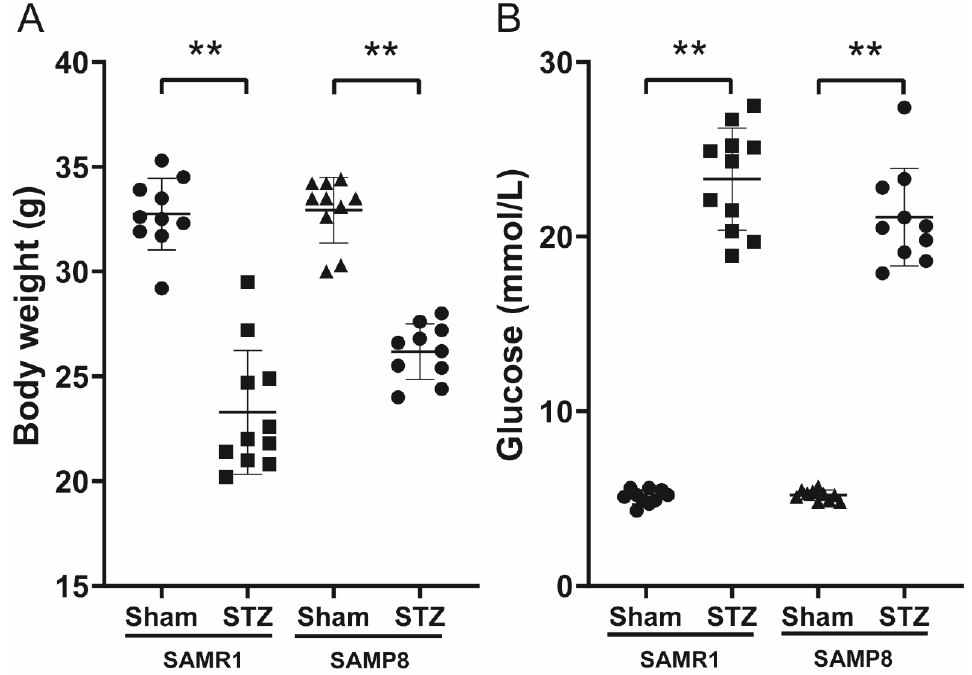
Figure 1. Body weight and FBG in control and diabetic mice. ( A ) Body weight changes of the mice for two weeks after diabetic model established ( n = 10–11 per group). ( B ) FBG levels of the mice for two weeks after diabetic model established ( n = 10–11 per group). ** p < 0.01 vs. SAMR1/SAMP8 control group. FBG: fasting blood glucose.